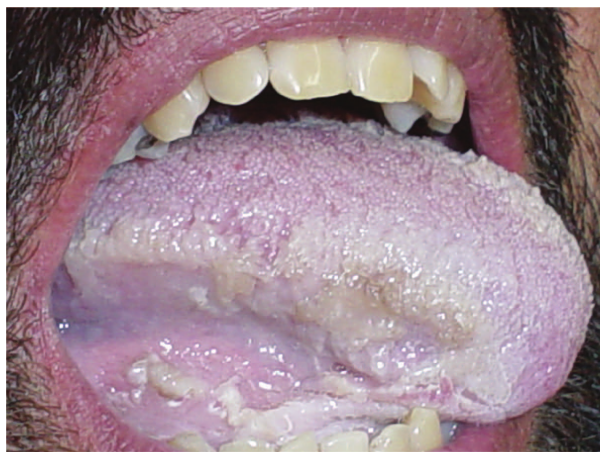
Figure 4 - Histopathologic image of tongue (H&E), showing an unusual hyperparakeratinization